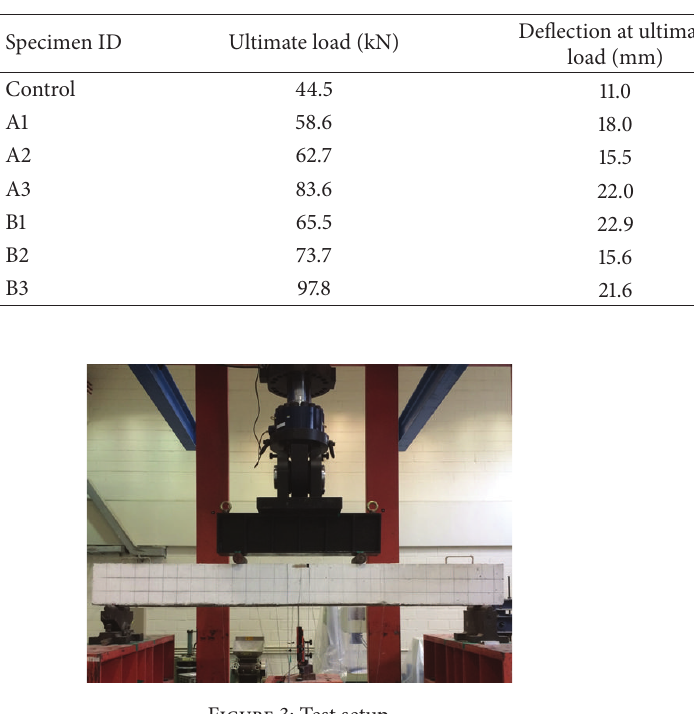
Table 6: Summary of experimental results.